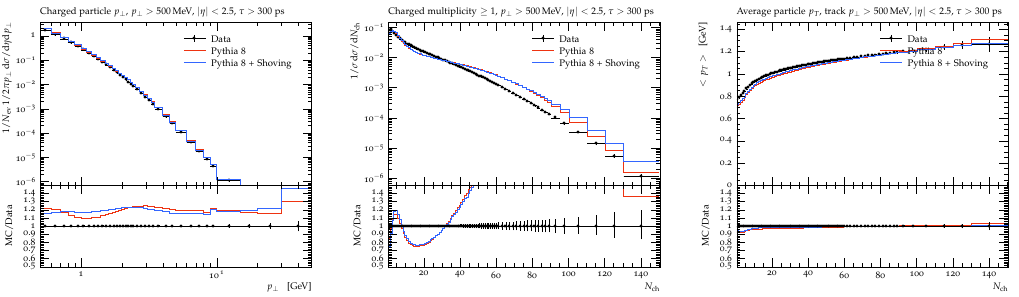
Figure 12 . Comparison of P YTHIA (non-diffractive) to P YTHIA + shoving to basic p ⊥ (left), multiplicity (middle) and h p ⊥ i distributions in pp collisions at